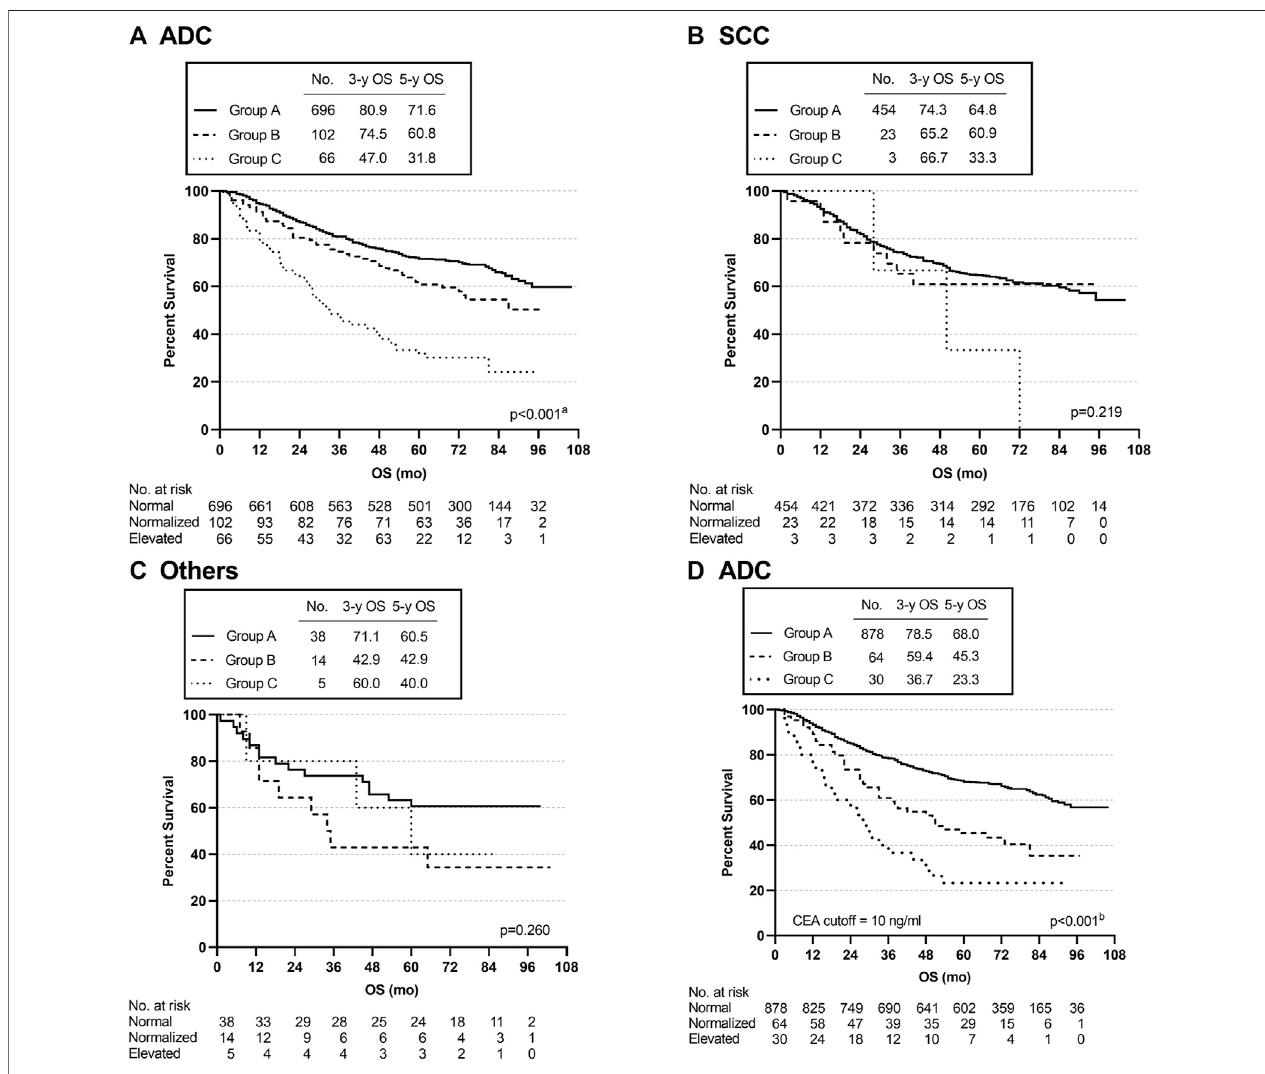
FIGURE4| Overallsurvivalcurvesofpatientswithdifferentsubgroups,groupedbypathologicaltypes. (A – C) K-McurvesforOSinADC,SCC,andOthers. (D) K-M curve for OS in ADC using a CEA cut-off of 10 ng/ml. a Group A vs. Group C, p < 0.001; Group A vs. Group B, p (cid:1) 0.014; Group B vs. Group C, p < 0.001. b Group A vs. Group B, p < 0.001; Group A vs. Group C, p < 0.001; Group B vs. Group C, p (cid:1)